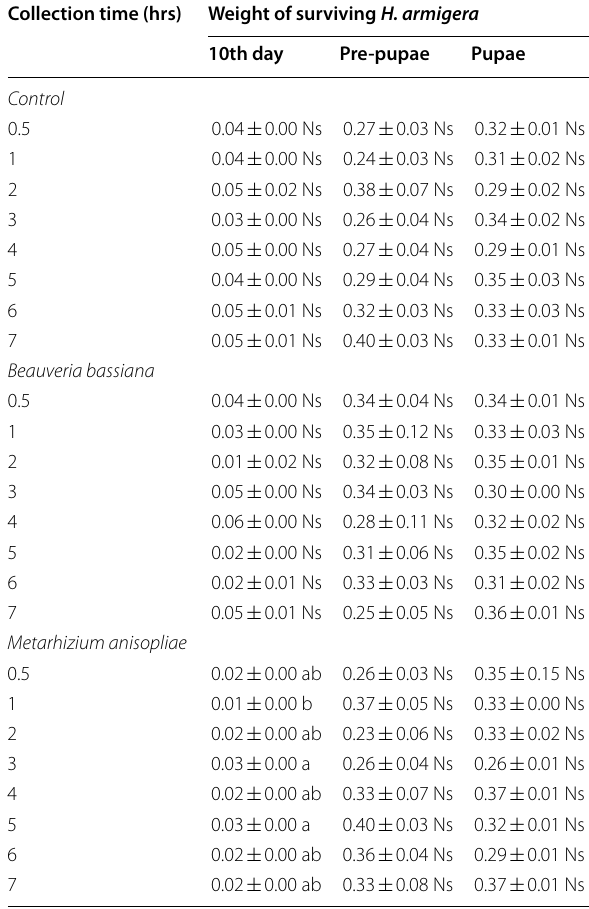
Means followed by the same lowercase letters in rows did not differ significantly by Tukey’s test at 5% probability Ns not significant an increase of 1.14% post-application. The gross repro- duction rate (GRR) of H. armigera at 6 h (296.14) was higher than that at the other evaluation times, however, but it did not differ from that at 1 and 2 h (Table 5). The M. anisopliae isolate was higher than the other’s average generation time ( T ) only during the first half an hour of collection (0.5 h). The net reproduction rate ( R 0 ) showed differences at all evaluation times, with the highest average of 281.0 observed 6-h post-applica- tion. The intrinsic rate of increase ( r ) was the lowest in the first half an hour (0.5 h), followed by a significant increase of 88% until the end of collection (7 h). The ¯ (cid:31) finite rate of increase ( ) showed no significant differ- ence in any of the leaf collection times after application.